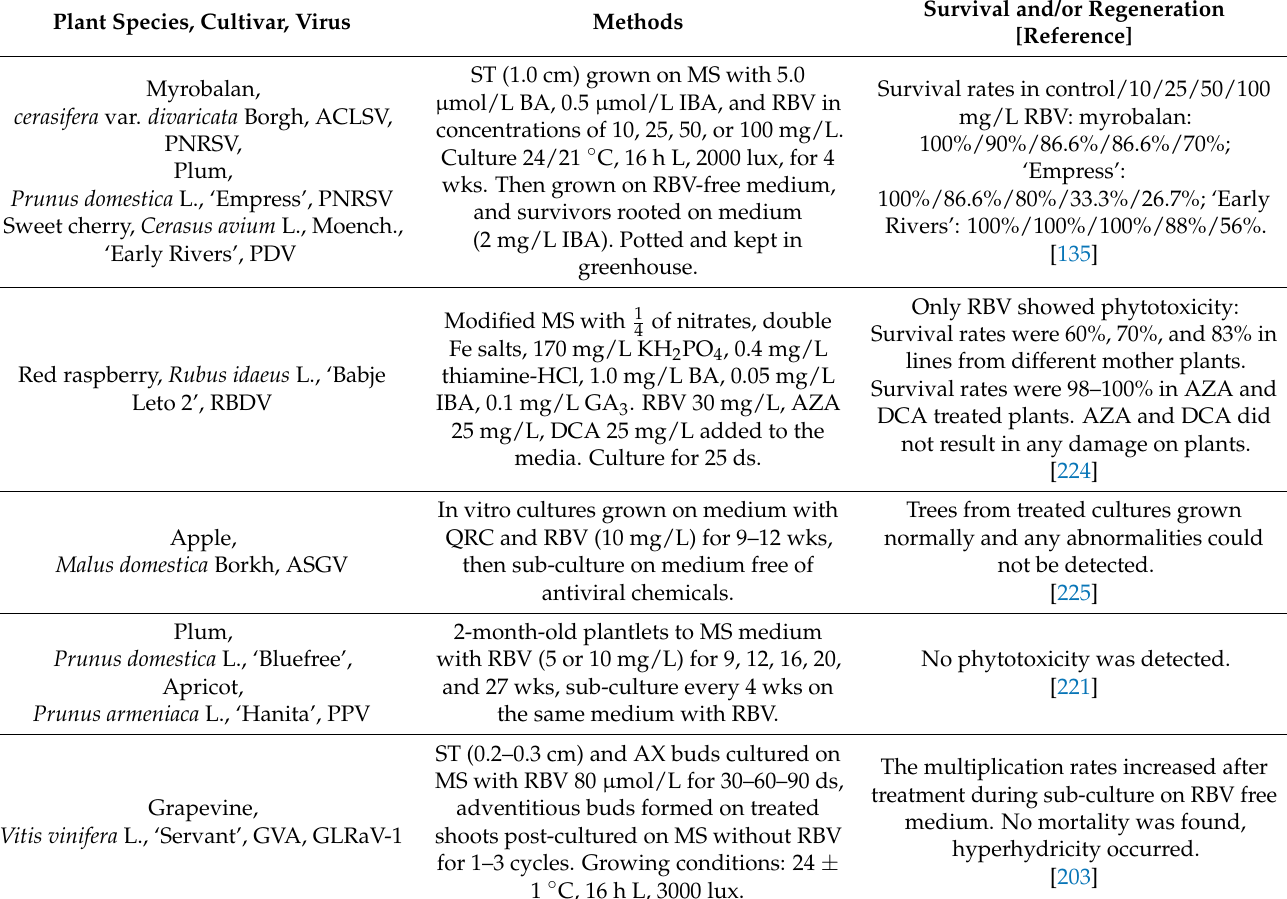
Table 6. Phytotoxic effect of the chemotherapy on woody plants. Plant Species, Cultivar,